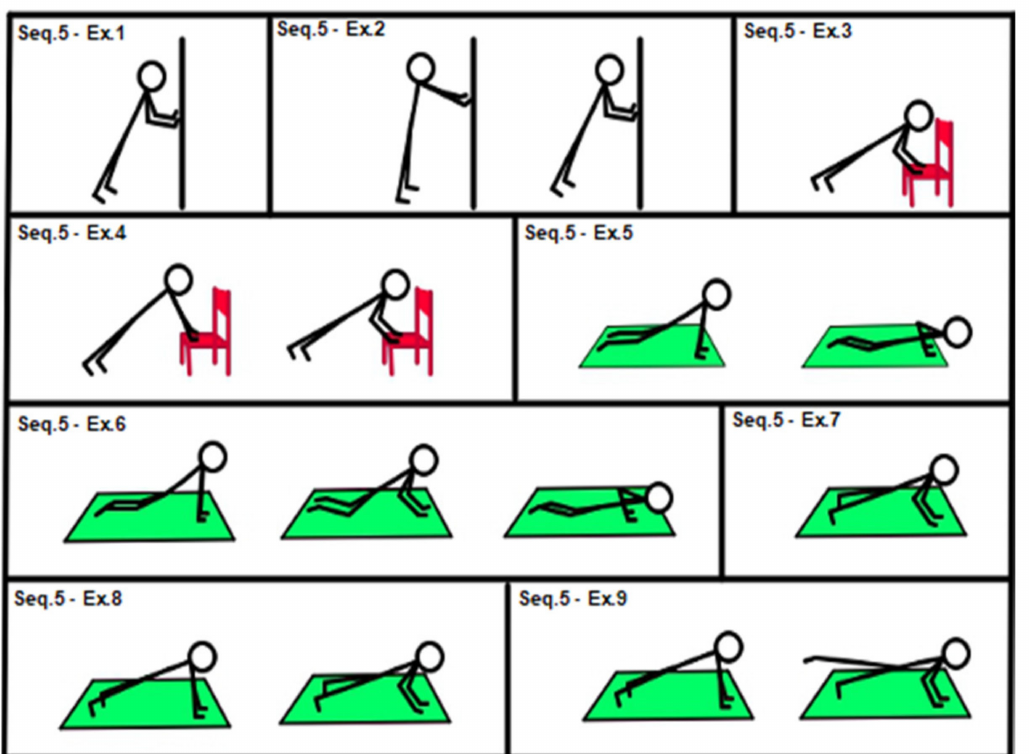
Figure 5. Sequence: 5 upper limbs, medium